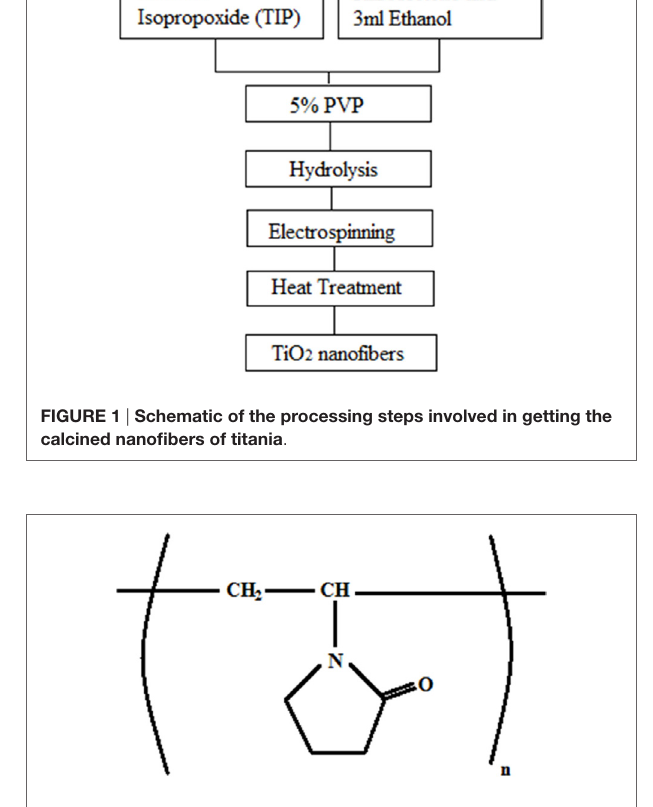
FigUre 2 | structure of PVP .